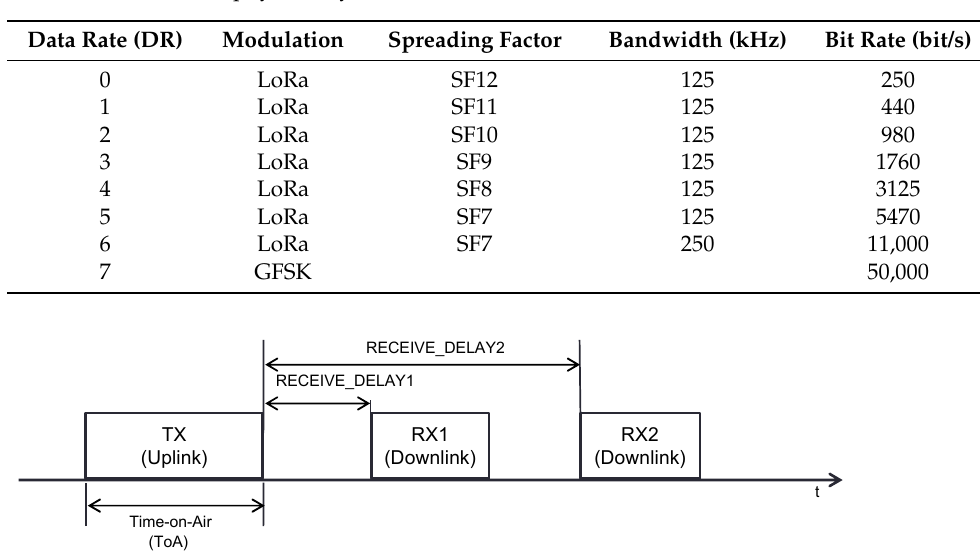
Table 1. DRs, SFs, and physical layer bit rates for the EU 868 MHz band channels.